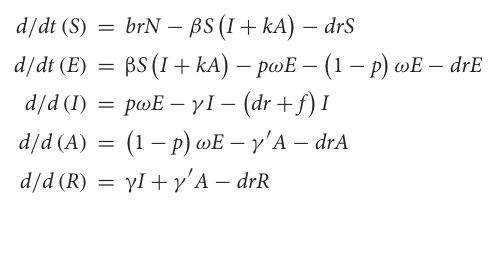
refer to the baseline of the transmission rate, time, a constant which adjusts the position of time, and the time span of the season cycle,